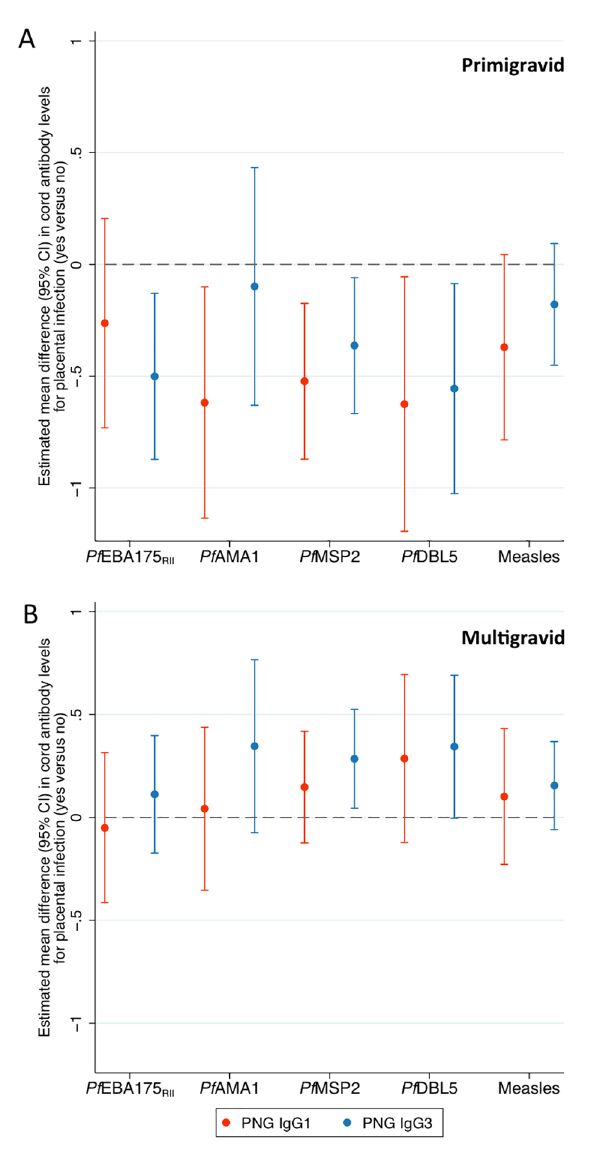
Fig 4. Association of placental infection with maternofetal antibody transfer efficiency in primigravid and multigravid Papua New Guinea women. Estimates and 95% confidenceintervals are presentedfor the mean difference in log 2 cord antibodylevels after adjustmentfor log 2 maternal antibody levels for (A) primigravid or (B) multigravidmothers with a P . falciparum placentalinfectioncomparedto mothers with no placentalinfection. Dashedline at 0 indicatesno difference in mean log 2 cord antibody levels. See S3 Table for a table versionof this figure, includingestimates for all women.